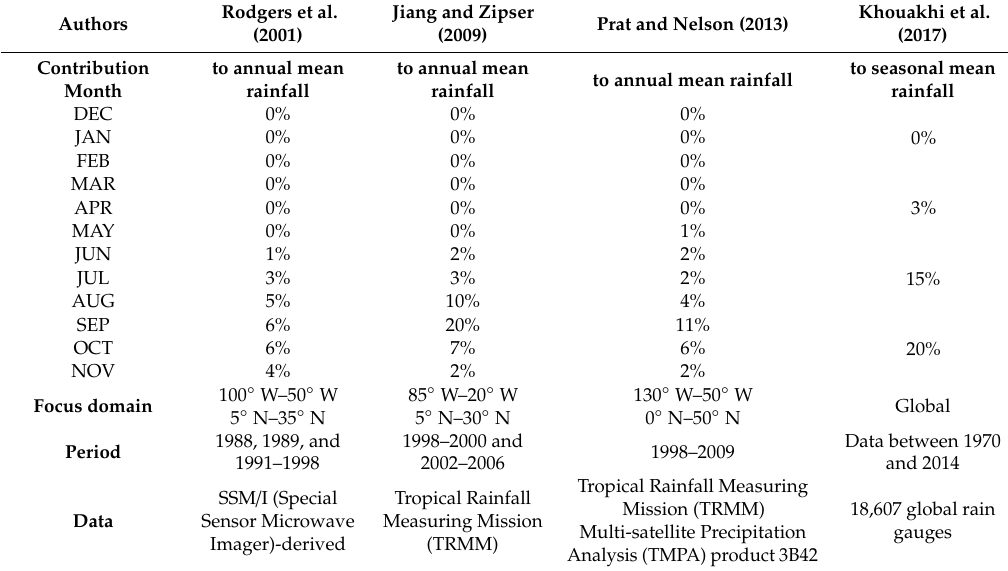
Table A1. Estimates of the TCs contribution to annual and seasonal mean rainfall, over regions that include the VCZ. Values reported by di ff erent